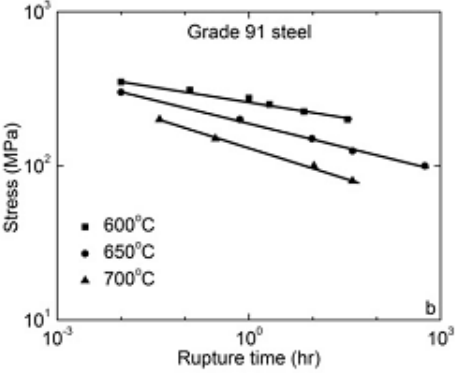
Figure 1. True stress versus creep rupture time for modified 9Cr-1Mo 91 steel specimens [1]